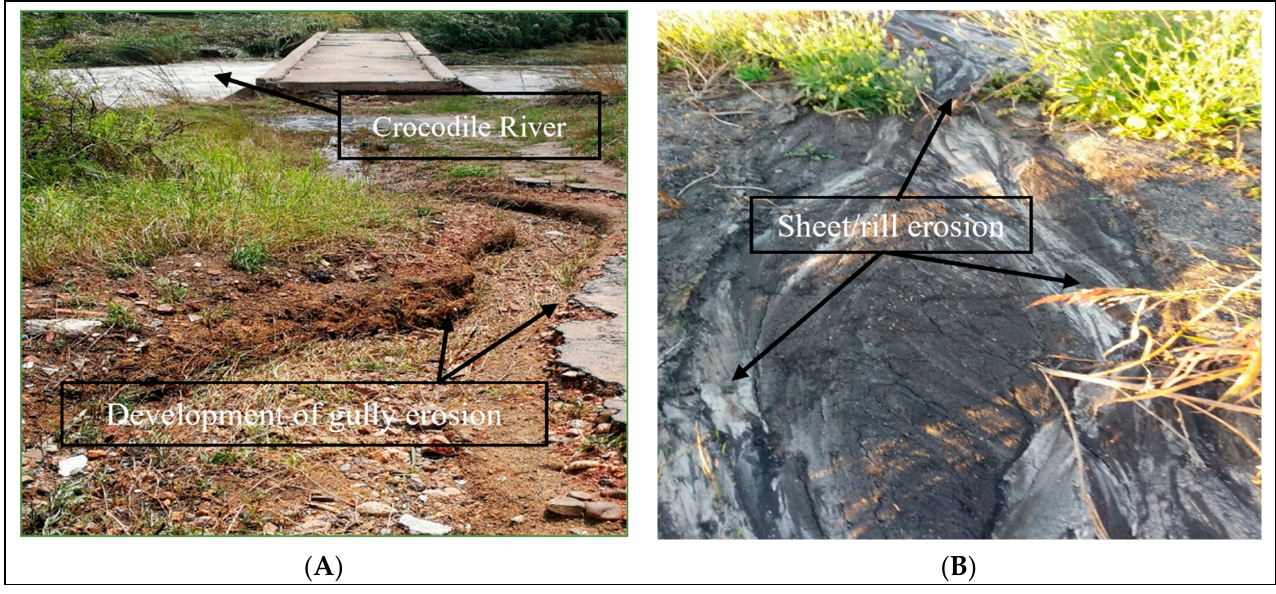
Figure 1. An illustration of an eroding field draining into the Crocodile River: ( A ) shows a develop- ing gully erosion and ( B ) shows evidence of sheet/rill erosion draining into the Crocodile